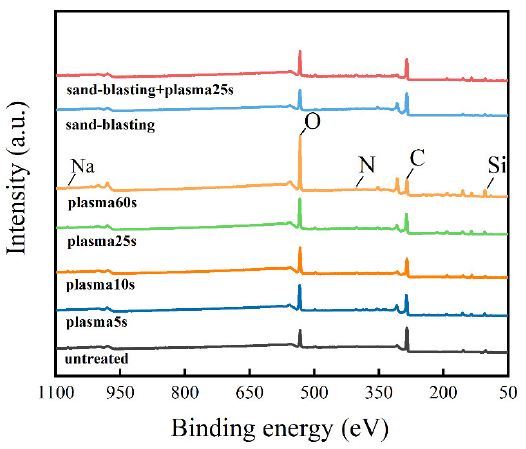
and the trace amount of Na on the surface of the sample is likely to from contamination by accidental hand contact with the sample during the experiment.